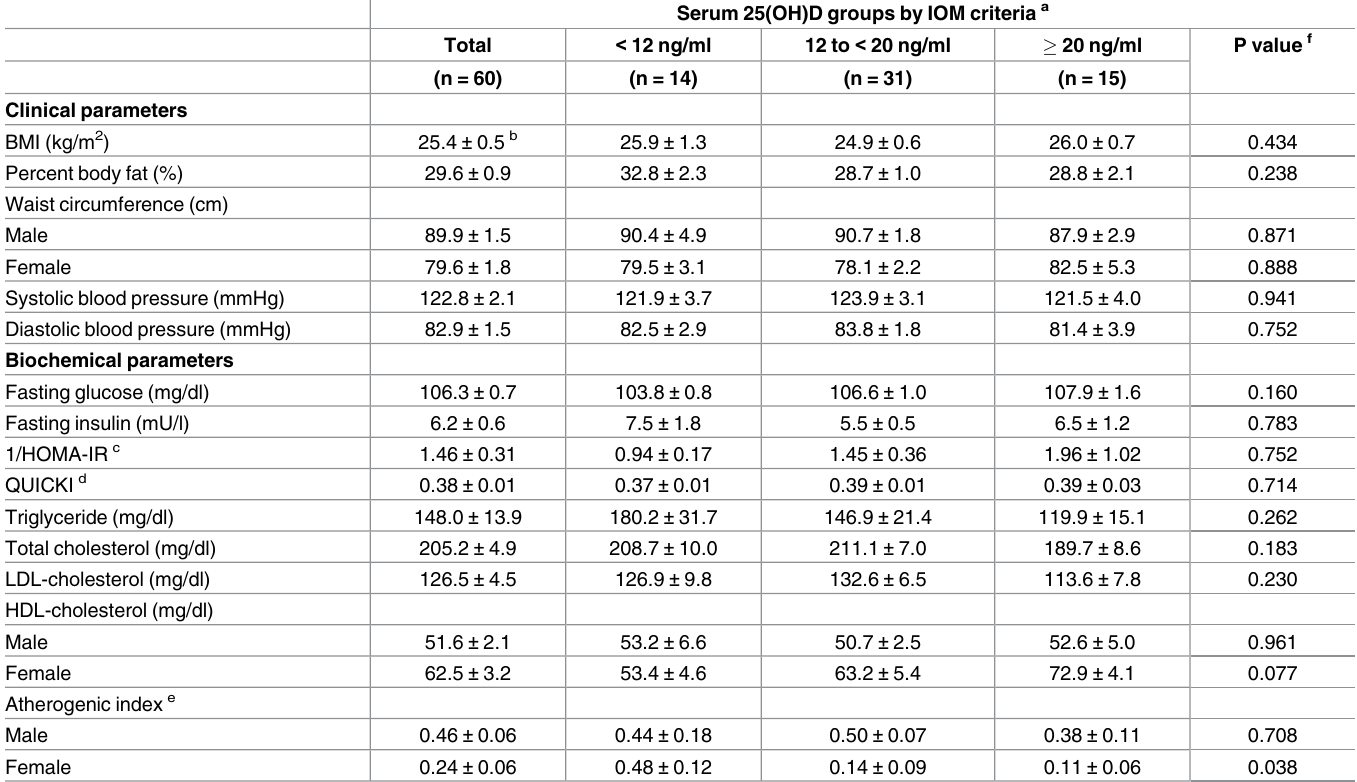
Table 2. Metabolic outcomes of Korean prediabetic adults by serum 25(OH)D level.